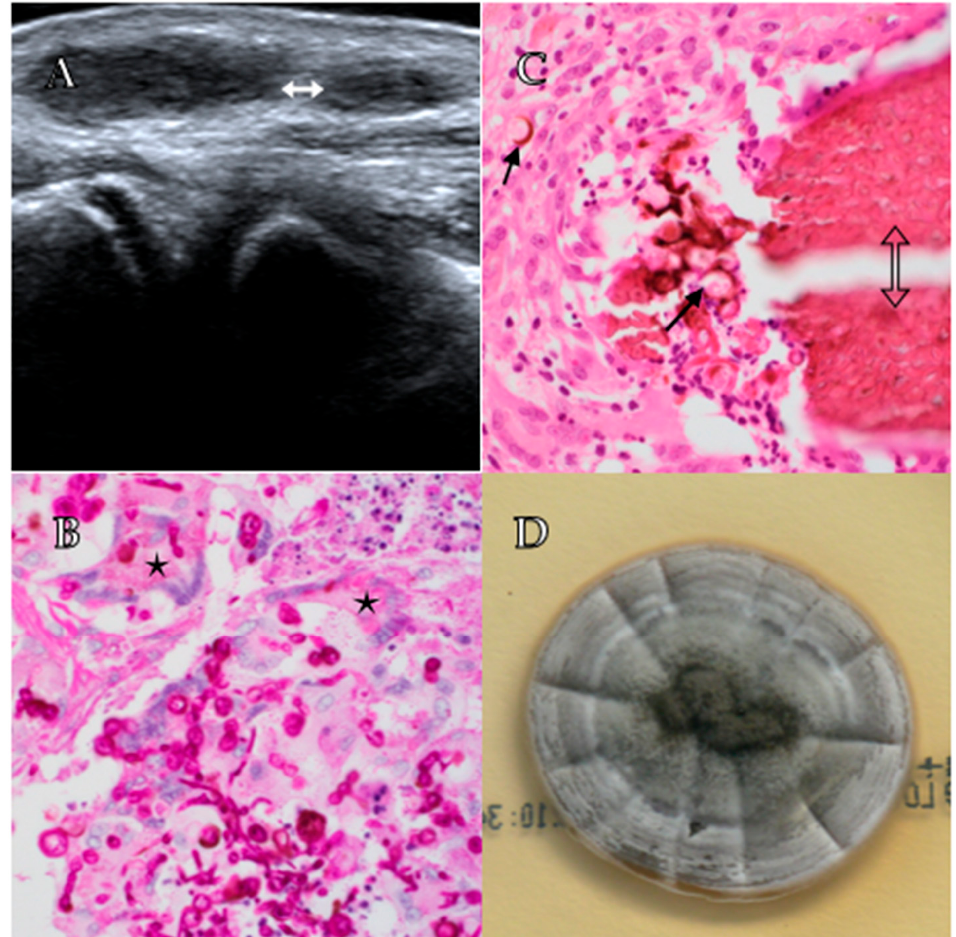
Figure 1. Panel ( A ) shows a right elbow ultrasound demonstrating two small ovoid lesions (white double-headed arrow). Panel ( B ) shows septate hyphae and multinucleated giant cells containing fungal elements (stars) at 600 × power on PAS staining. Panel ( C ) shows a grain (hollow double- headed arrow) with surrounding thick walled, brown fungal cells (arrows) at 600 × power on H&E staining. Panel ( D ) shows fungal growth after 14 days on Sabouraud’s dextrose agar demonstrating grey and purple colonies with radial folding.